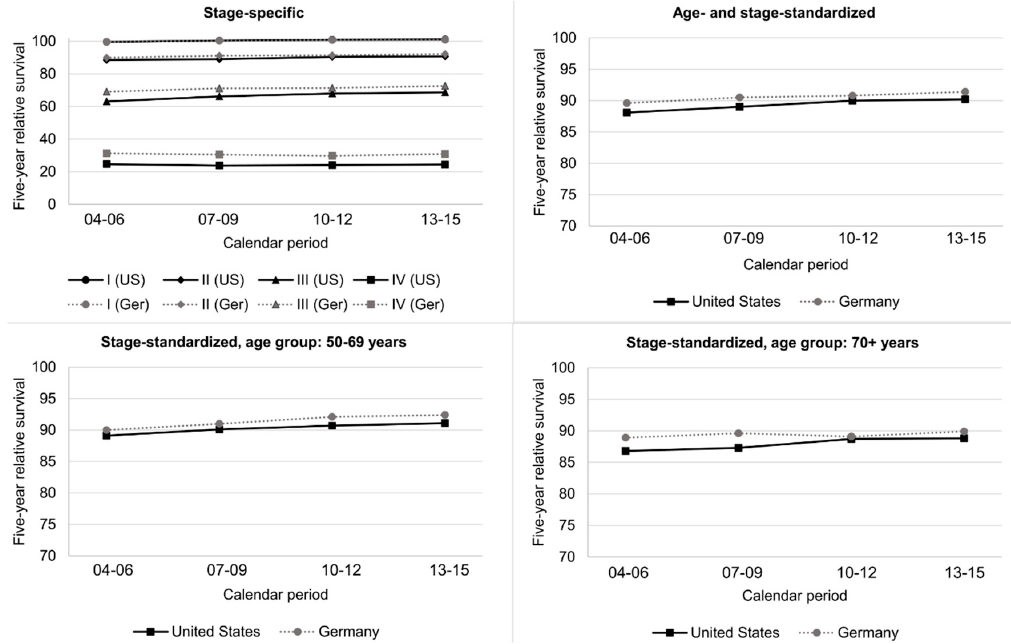
Figure 3. Trends in age-standardized and age-specific five-year relative survival in Germany, Saarland and the United States.